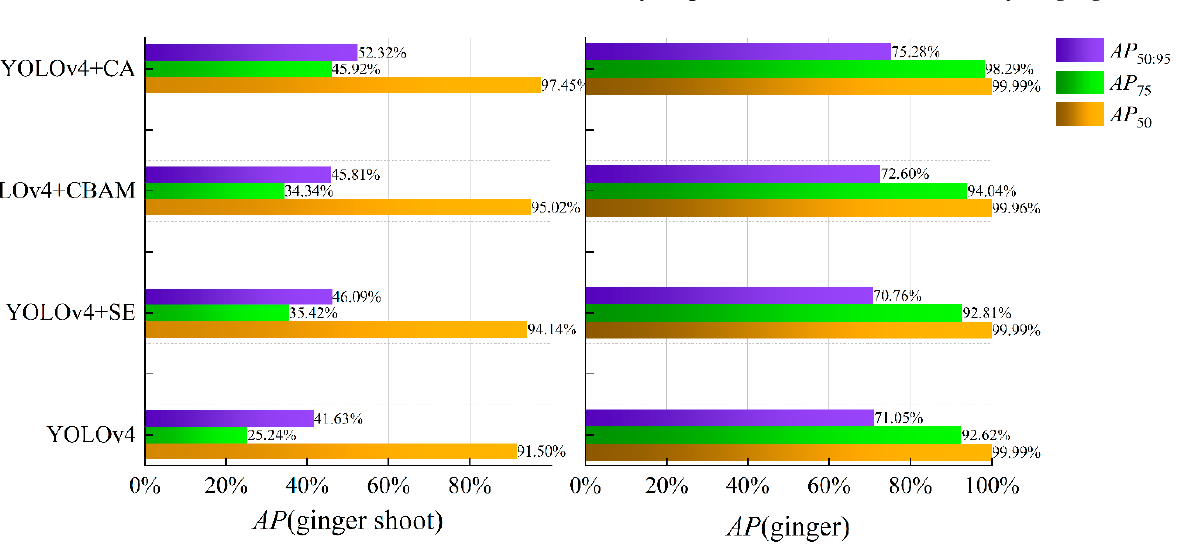
Figure 11. Contrast graph of different attention modules.